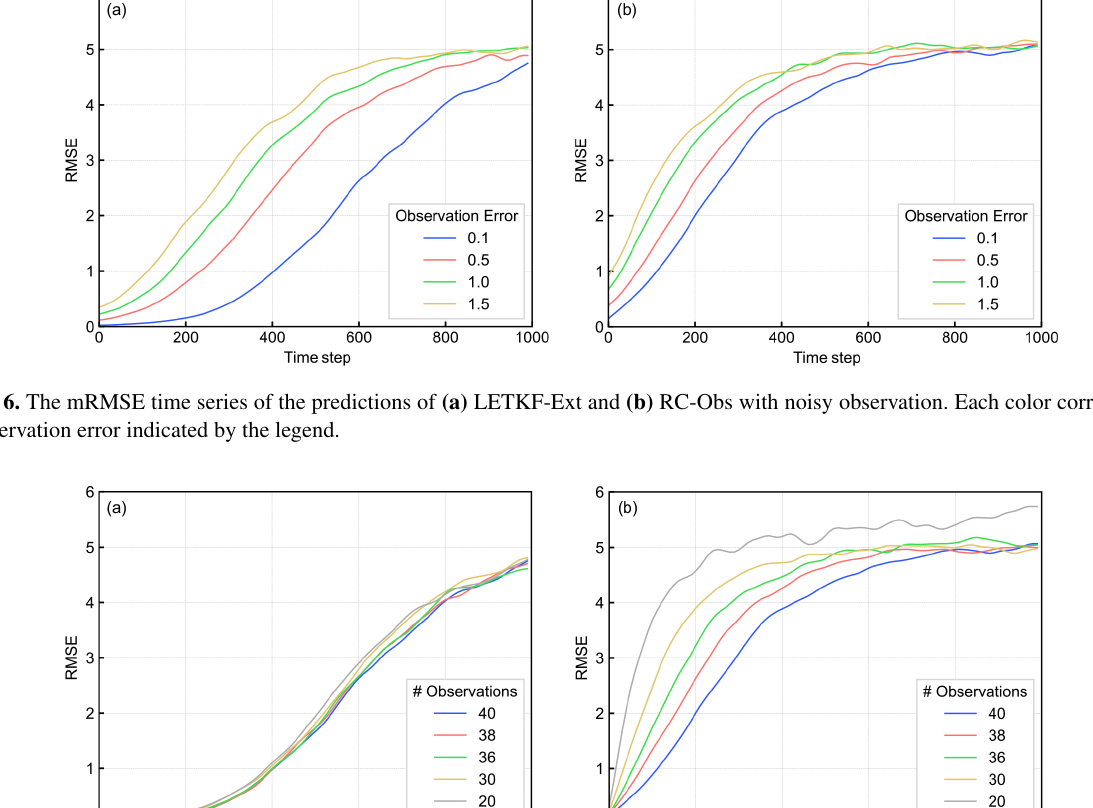
Table 2. Summary of three prediction